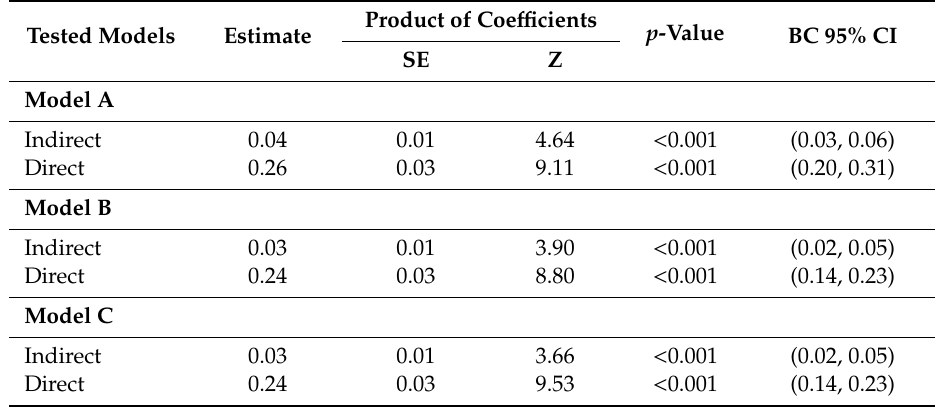
Table 3. The direct and indirect e ff ect of individual health literacy on personal preventive behaviours through COVID-19 information sharing with family members.